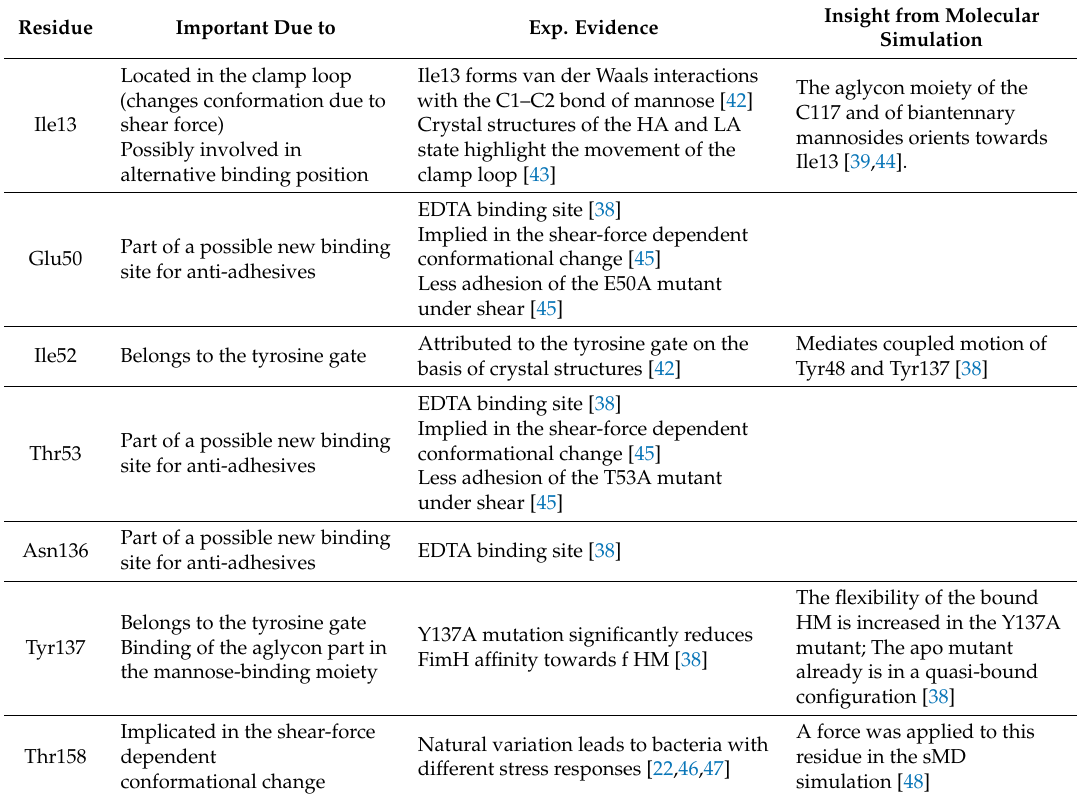
Table 1. Residues from the FimH lectin domain important for its function (and discussed in this review) are listed. These residues are either (i) involved in binding of the algycon moiety in the FimH mannose-binding pocket, (ii) important for the conformational change of FimH or (iii) have been shown to be involved in promising alternative binding positions. For each residue the available experimental evidence as well as the insight gained from molecular simulation shortly summarized. The most promising residues are highlight by an asterisk. The sequence from the UPEC strain UTI89 was used. Residue Exp. Evidence